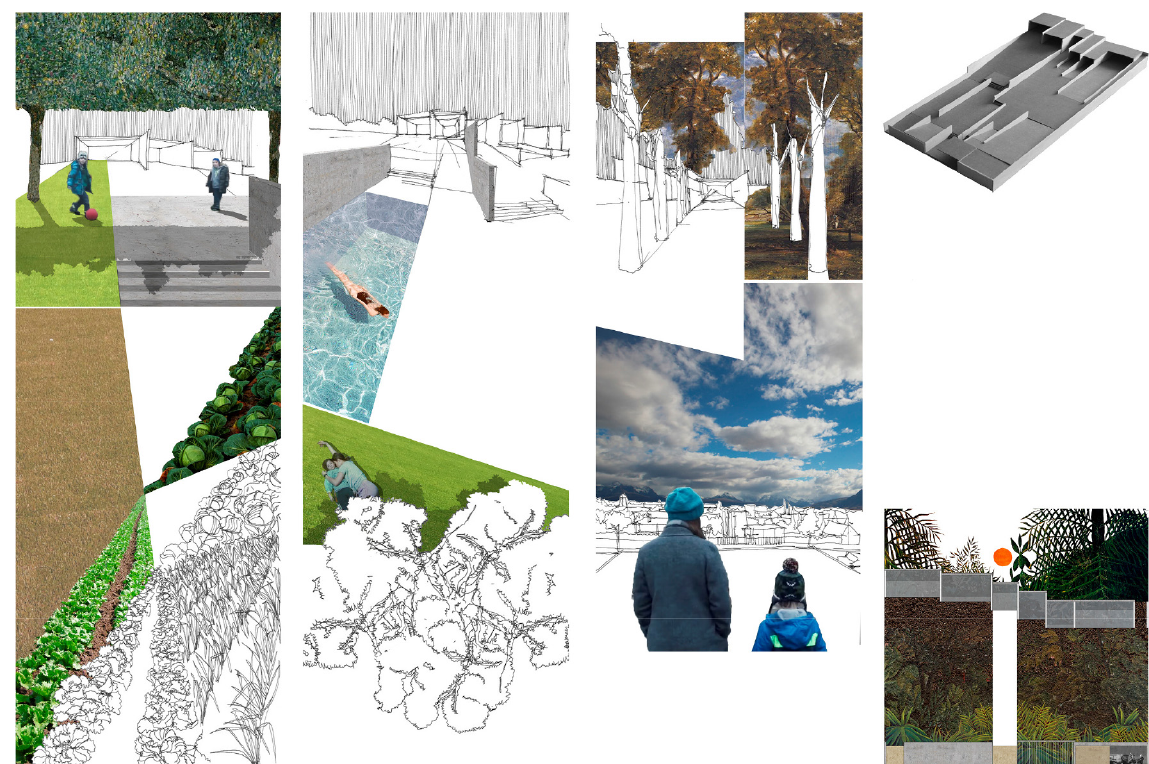
Figure 8. The room. Student: Carlos Puente